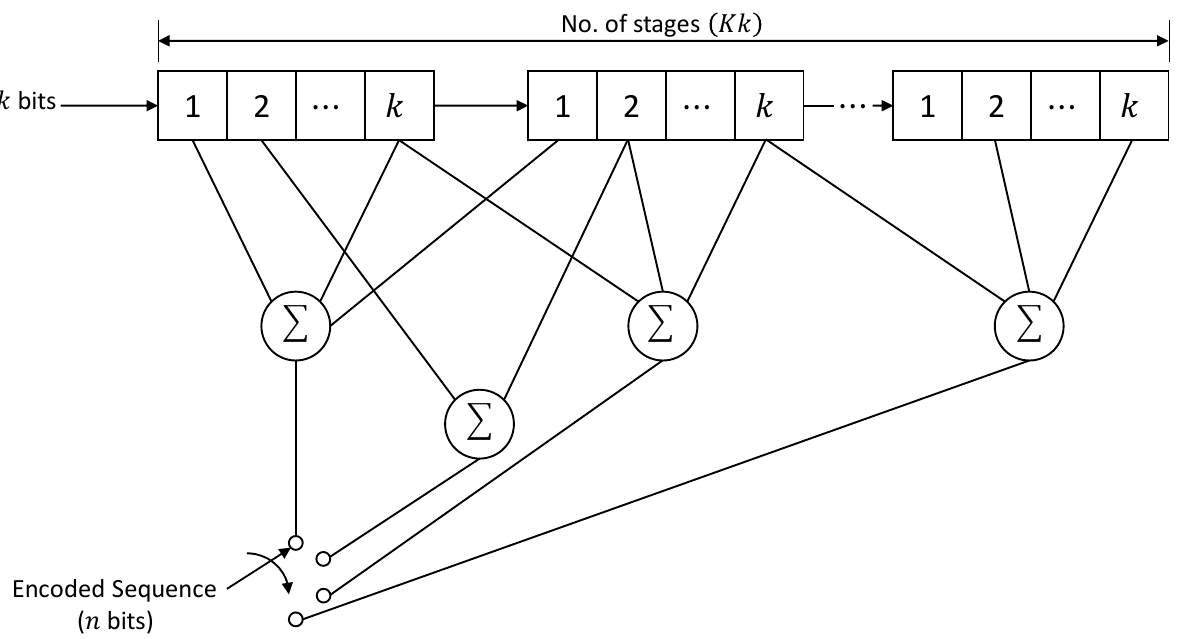
Figure 1. A typical convolutional encoder.